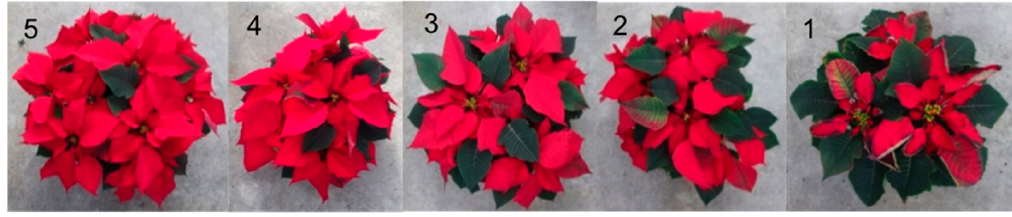
Figure 2. Photos of shoots used as the rating standard for visual rating. Numbers on the photo are ratings on a scale from 5 to 1.